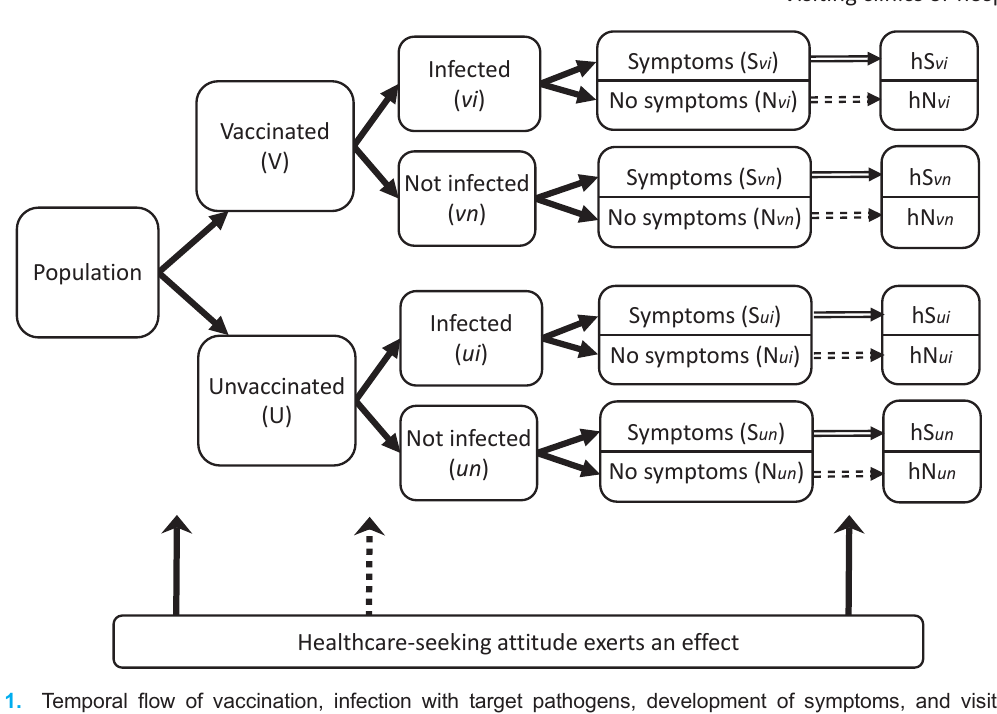
Figure 1. Temporal fl ow of vaccination, infection with target pathogens, development of symptoms, and visits to clinics or hospitals, as well as the in fl uence of a healthcare-seeking attitude. Arrows from “ Population ” to “ Symptoms / No symptoms ” indicate choice of receiving vaccination and chance of infection with pathogens and display of symptoms. Arrows from “ Symptoms / No symptoms ” to boxes below “ Visiting clinics or hospitals ” indicate probability of the visit. Solid arrows indicate higher probability than dotted ones in general. Solid arrows from “ Healthcare-seeking attitude exerts an e ff ect ” indicate de fi nite in fl uence on behavior of receiving vaccination and visiting clinics or hospitals, which are the major issues of this commentary. A dotted arrow indicates possible in fl uence on chance of infection with pathogens through preventive health